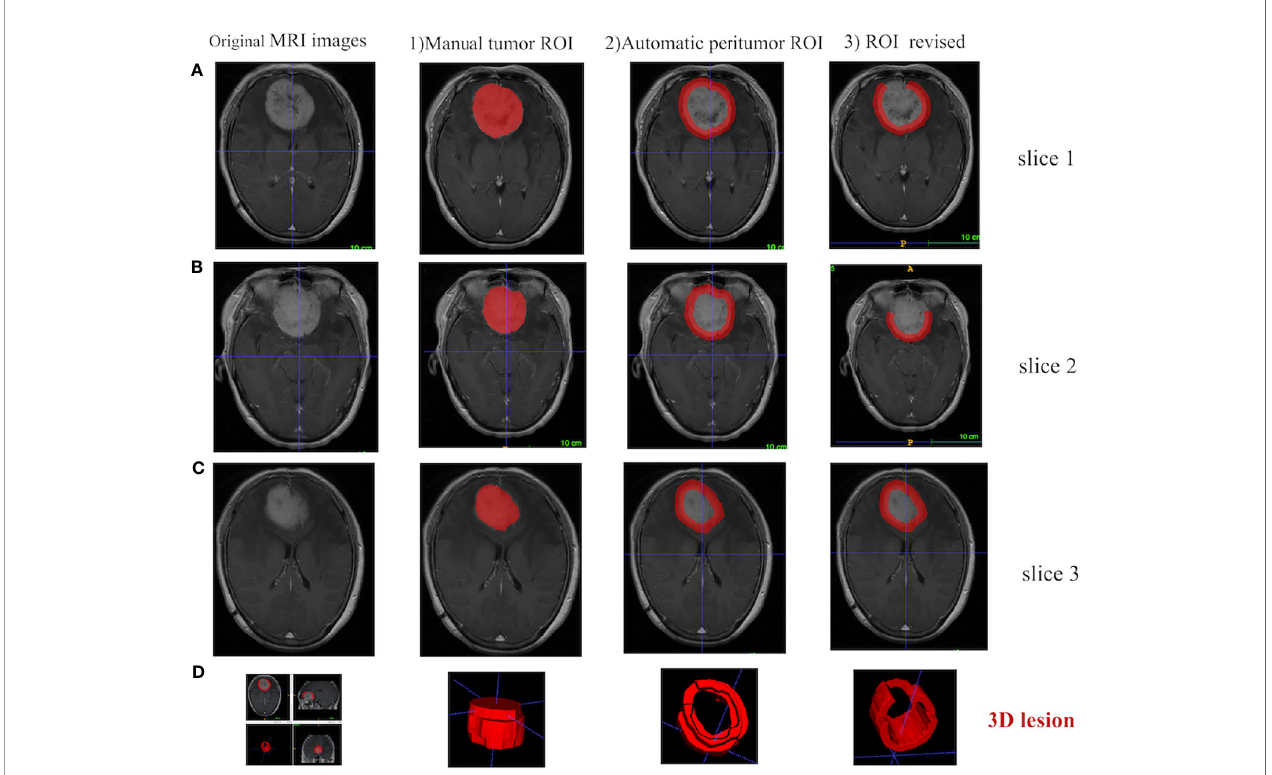
FIGURE 2 | Different ROI segmentation conditions are displayed in 2D and 3D in ITK-SNAP software, including the original image, the manually segmented tumoral ROI, and the semi-automatically segmented tumor-to-brain interface ROI. (A) Tumor located in anterior cranial fossa with overlap of non-brain tissues (i.e., bone) after 5 mm expansion, which is manually revised to only keep tumor-to-brain interface. (B) The same tumor with overlap of non-brain tissues (i.e., postorbital tissues) after 5 mm expansion, which is manually revised to only keep tumor-to-brain interface. (C) The same tumor without any overlap of non-brain tissues after 5 mm expansion. (D) 3D visualization. ROI, region of